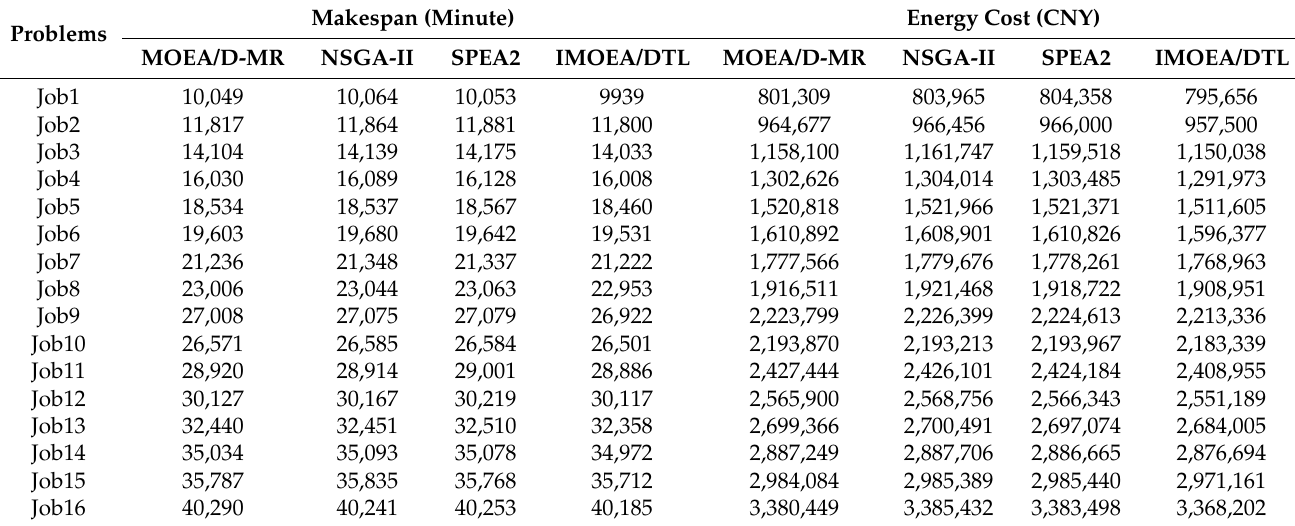
Table 12. The average makespan and average energy cost obtained by MOEA/D-MR, NSGA-II, SPEA2, and IMOEA/DTL. Problems